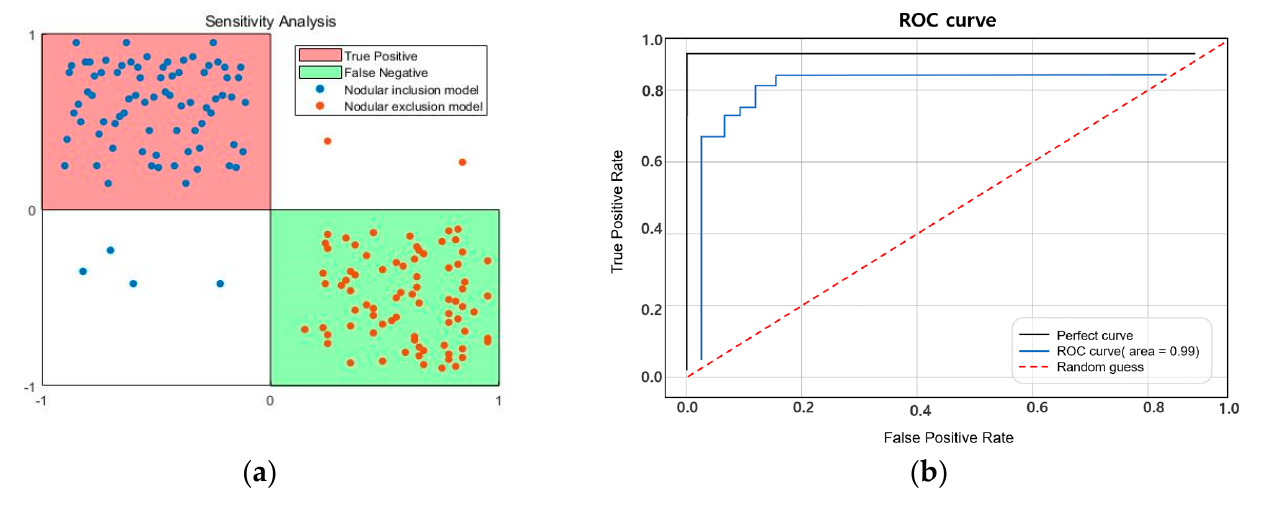
Figure 34. ( a ) Sensitivity analysis. ( b ) ROC curve.